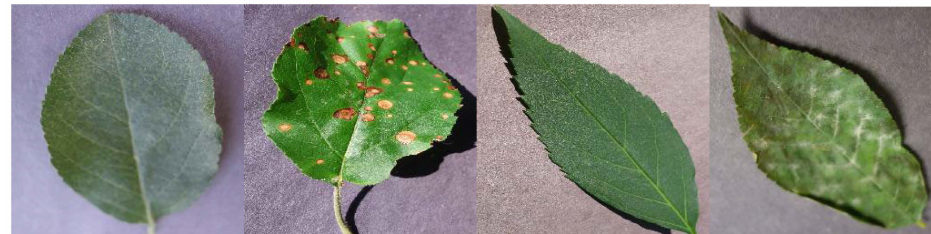
Figure 6. Example images of PlantVillage dataset used in our experiment. Left to right: images of healthy apple leaf, apple leaf with black rot disease, healthy cherry leaf, and cherry leaf with powdery mildew disease.